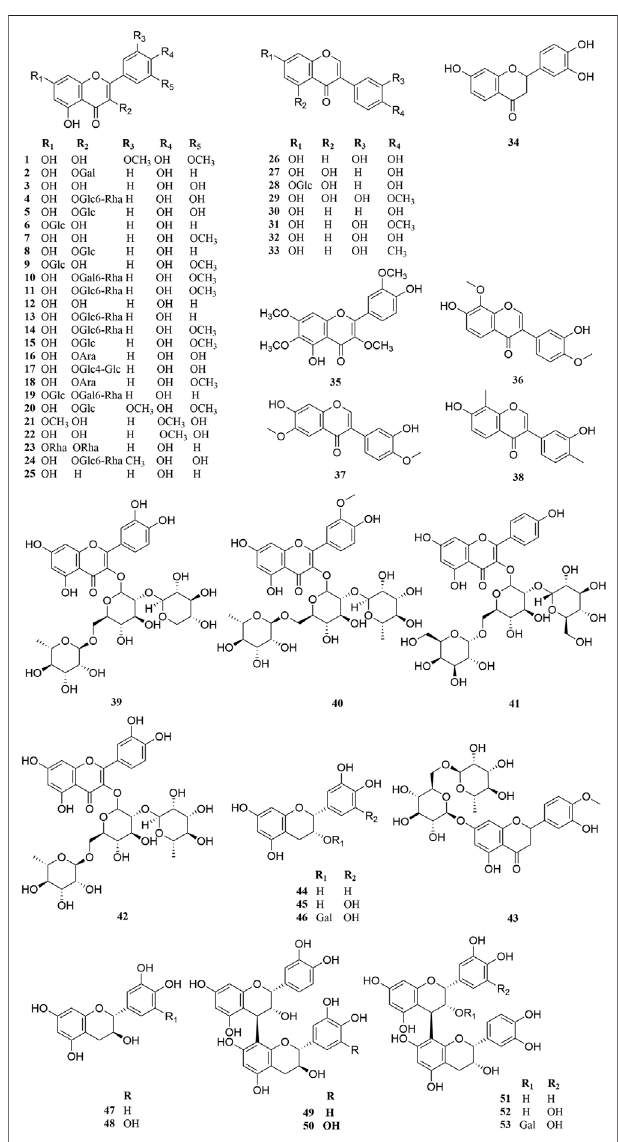
FIGURE 3 | Chemical structures of fl avonoids ( 1 – 53